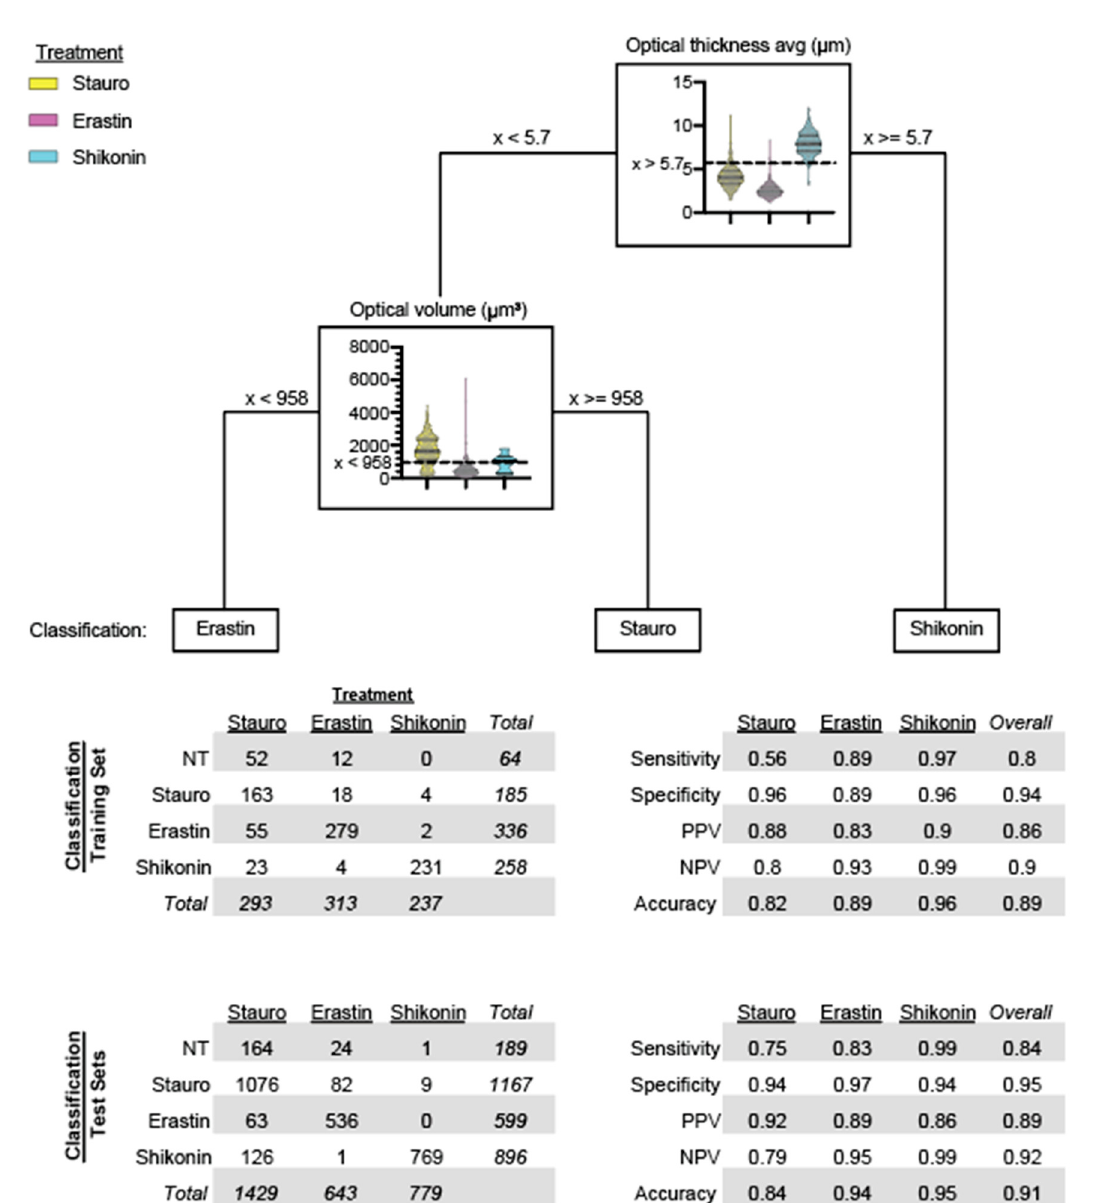
Figure 7. Two-node decision tree for classifying form of programmed cell death. Graphs depict all datapoints from Training Set not yet classified at each node. Dotted lines and “x” indicate threshold used to classify. Tables provide raw results and calculated metrics of accuracy for Training Set and combined Test Sets.